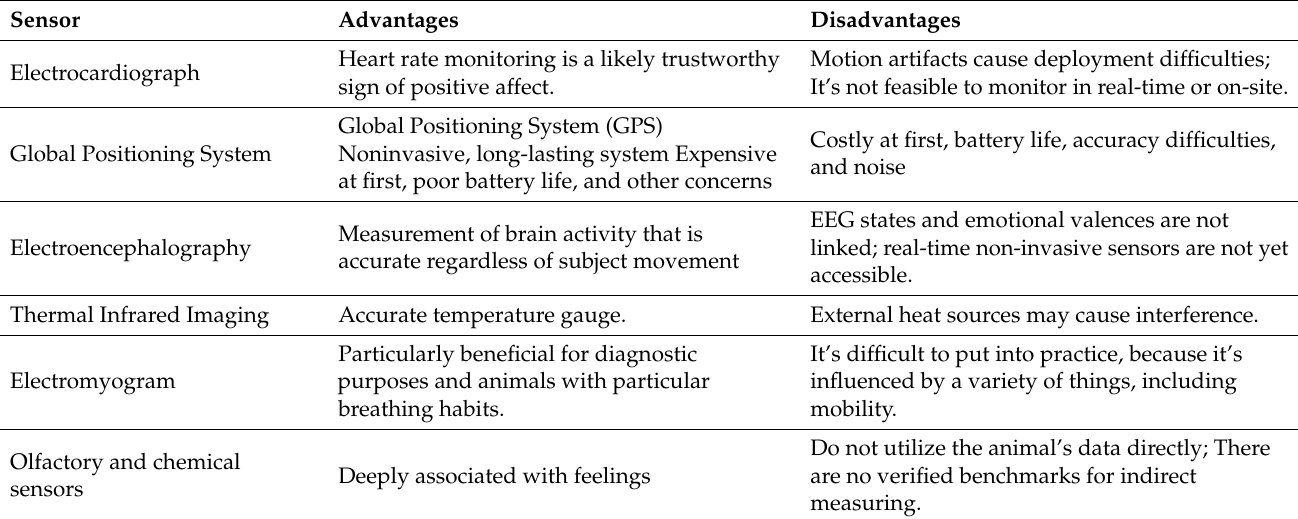
Table 2. Sensors for animal health